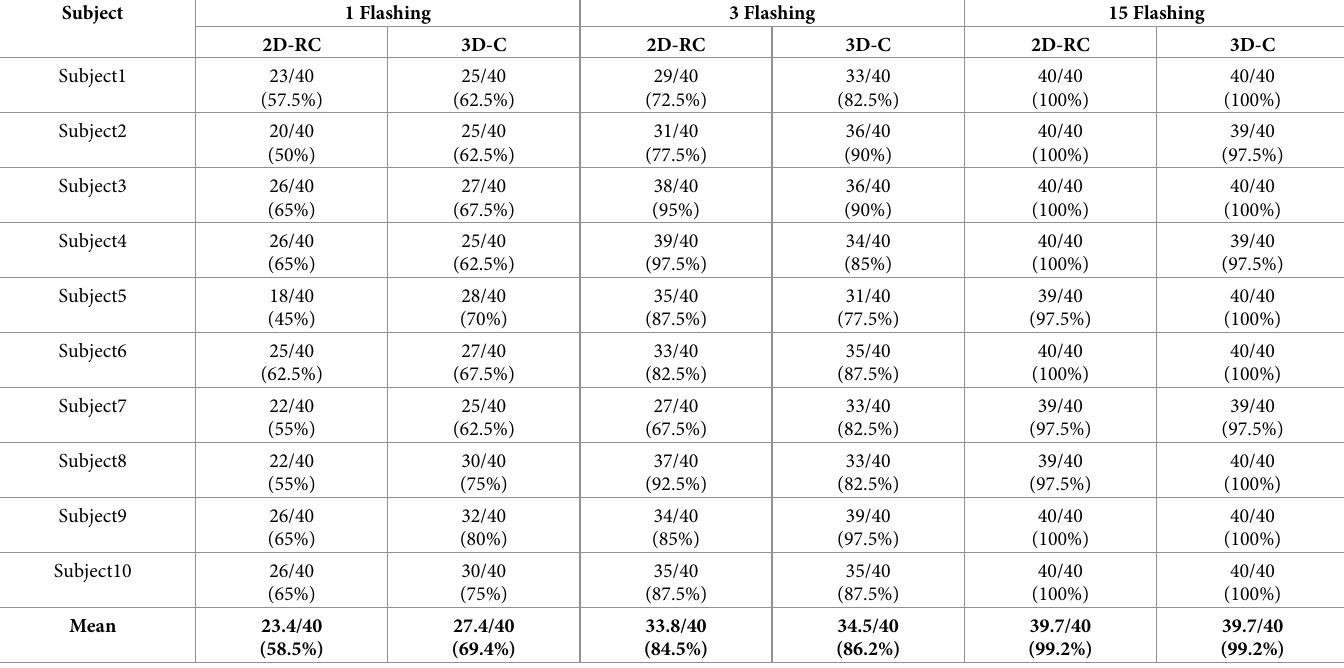
Table 4. Character detection accuracies obtained for both